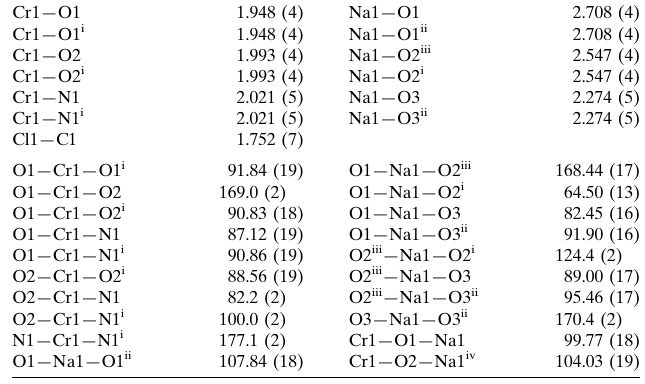
Selected geometric parameters (A˚ , (cid:3)